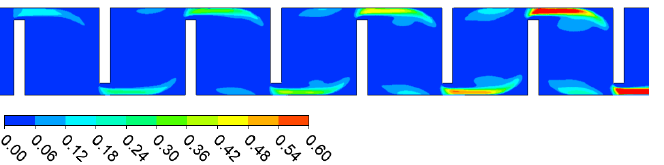
Figure 3. Example distribution of non-dimensional kinetic energy e in the axial direction in the staggered seal for 𝑝 𝑖𝑛 /𝑝 𝑜𝑢𝑡 = 2, 𝑇 𝑖𝑛 = 300 𝐾 , 𝑝 𝑜𝑢𝑡 = 10 5 𝑃𝑎 .